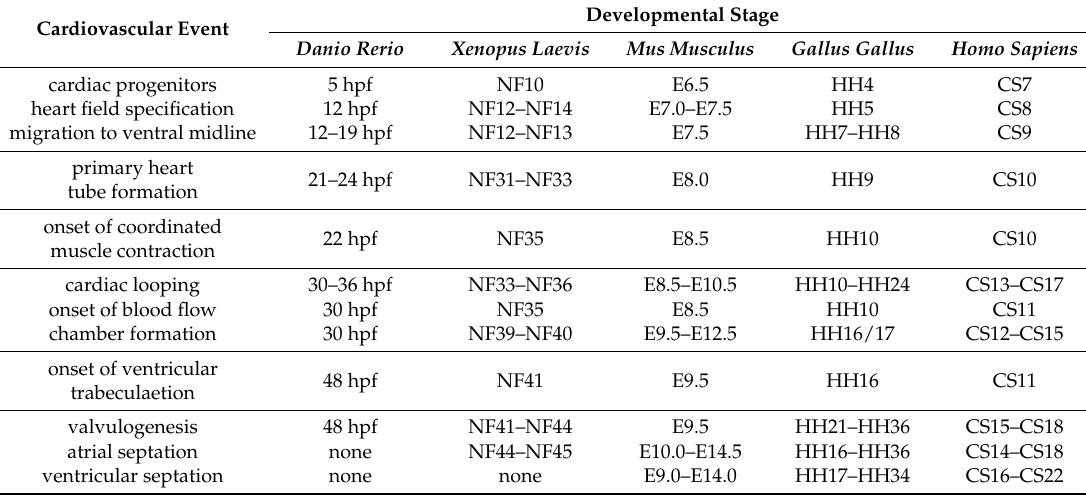
Table 1. Comparative timeline of events in cardiovascular development in different species. Based on